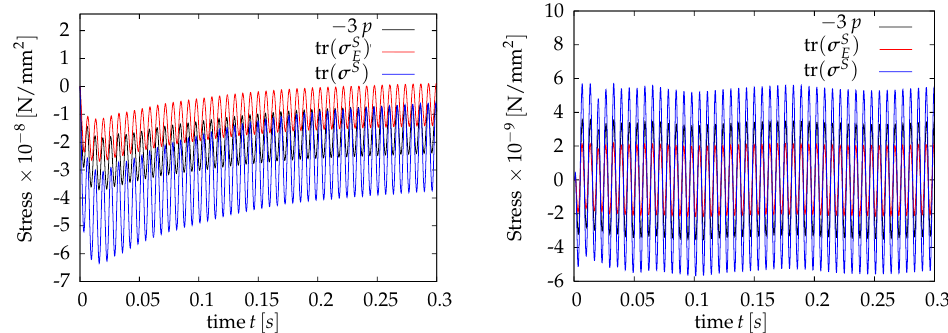
Figure 9. Total solid stress, solid effective stress, and pore-pressure changes over the time range [ 0, 0.3 ] s at point A ( left ) and point B ( right ) for the case of excitation frequency f exc